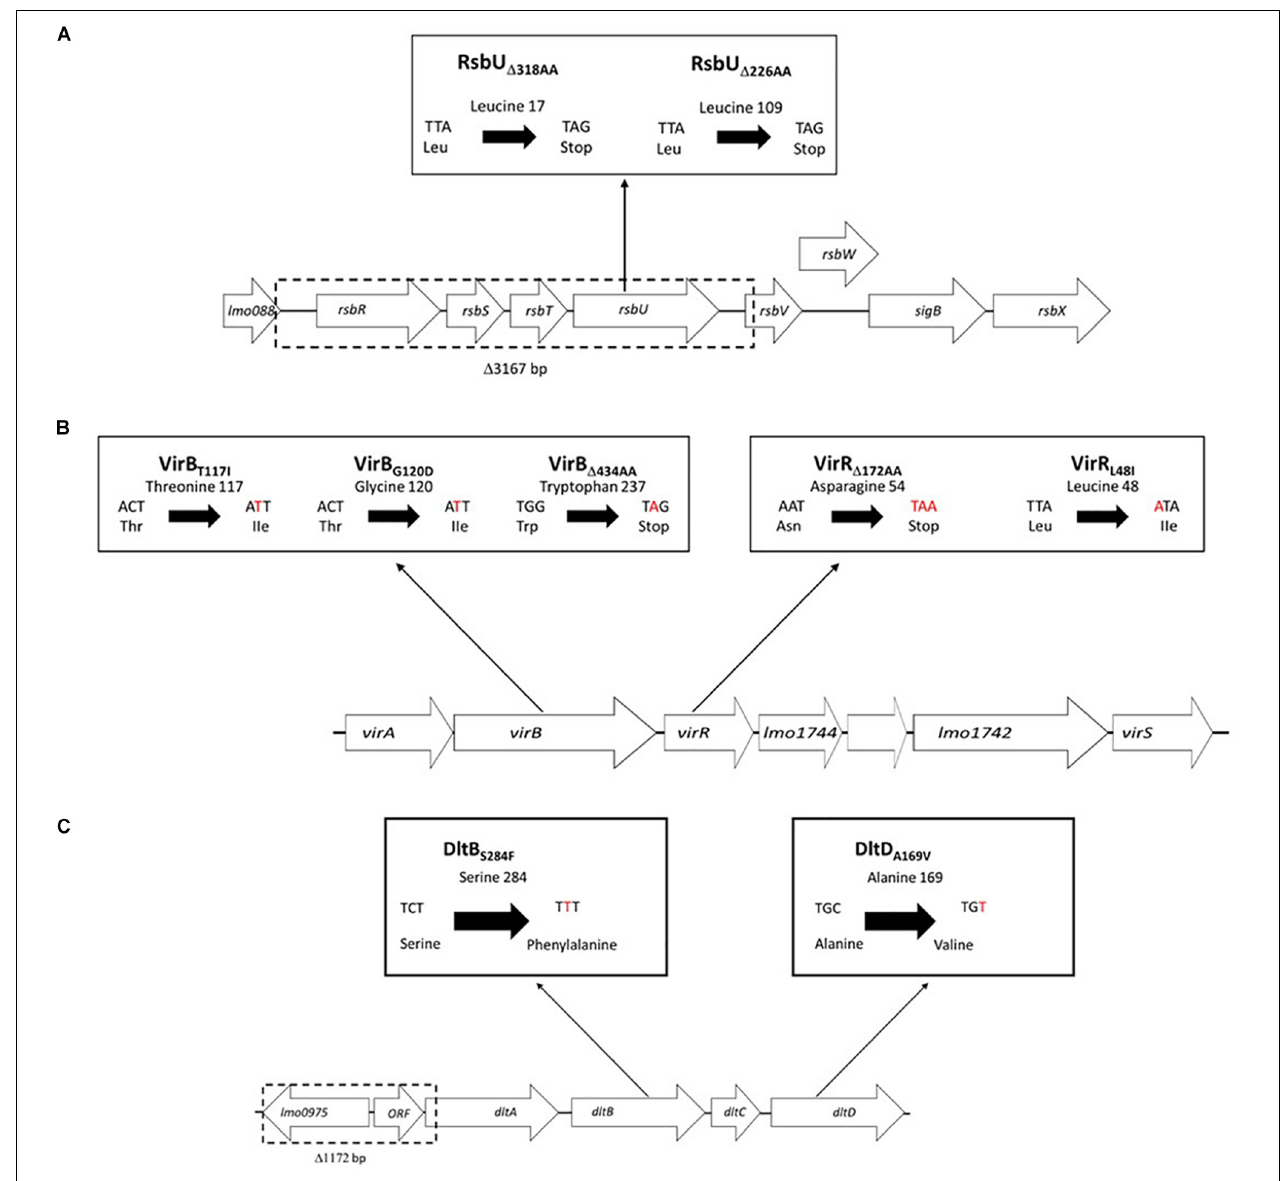
FIGURE 8 | Schematic representations of the sigB , vir, and dlt operon associated mutations uncovered among the nisin sensitive L. monocytogenes field strains from our study. (A) In the sigB operon single base deletions causing RsbU truncations (RsbU (cid:49) 318 AA and RsbU (cid:49) 226 AA ) and a 31367 bp deletion (causing loss of rsbR , rsbS, and rsbT genes and part of rsbV ) were detected. (B) In the vir operon point mutations causing amino acid substitutions and single base deletion truncated proteins were detected in the virR and virB genes. (C) In the dlt operon a 1172 bp deletion (causing loss of lm00975 , predicted hypothetical protein